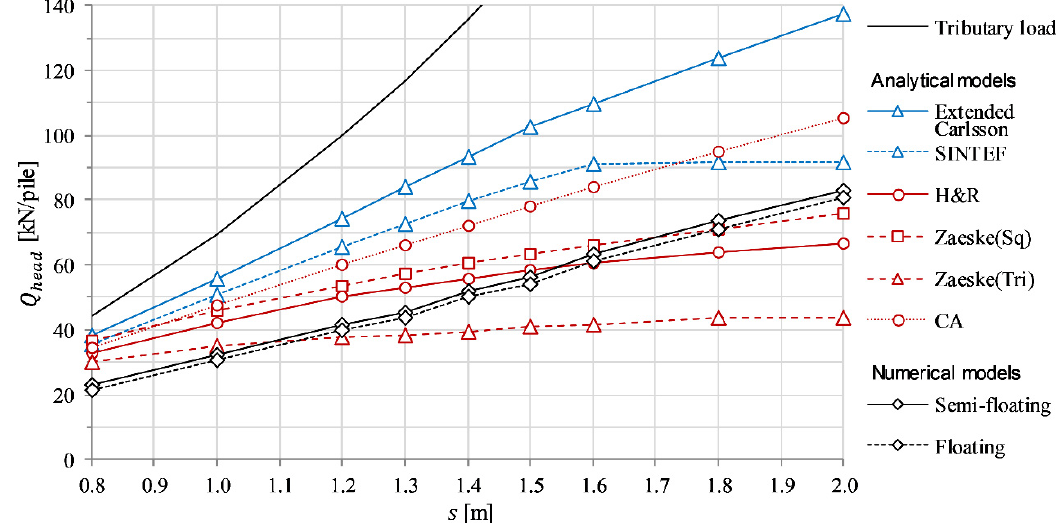
Figure 19. Comparison of the pile head load ( Q head ) from the numerical and analytical results, as well as the tributary load, plotted against s